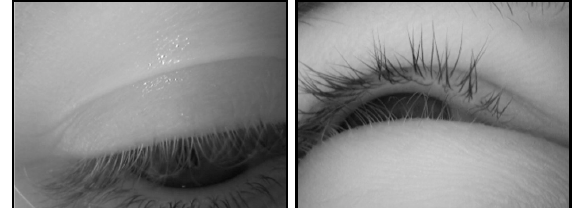
Figure 11. Track loss due to eye position. With the eye camera positioned to optimize fixations on objects directly in front of the observer, eye movements directed to the ground (left) and far overhead (right) cannot be tracked.